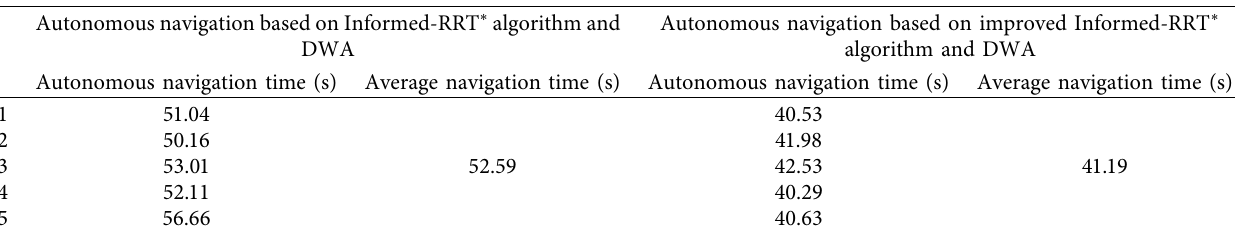
Table 3: The experimental results of the autonomous navigation time of the robot in the raster map with and without the improved Informed-RRT ∗